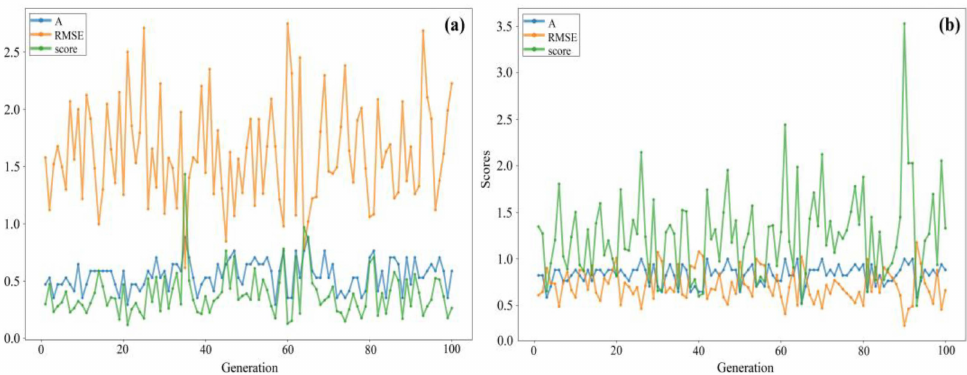
Figure 10. ( a ) Prediction results without pretreatment, ( b ) Prediction results without data